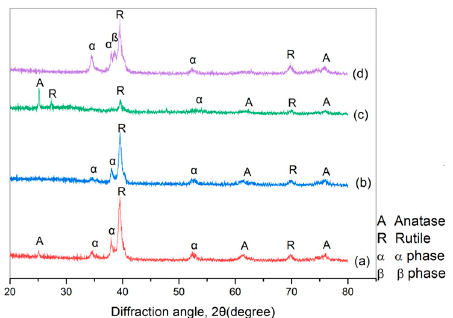
Figure 5. X-ray diffractograms of samples: The control group ( d ) and MAO coatings obtained at various applied voltages in a constant current of 32 mA and time processing equal to 15 min: MAO_32_15_200 ( a ), MAO_32_15_300 ( b ), MAO_32_15_400 ( c ) (the presented results are representative for three analyses of each surface treatment specimens).